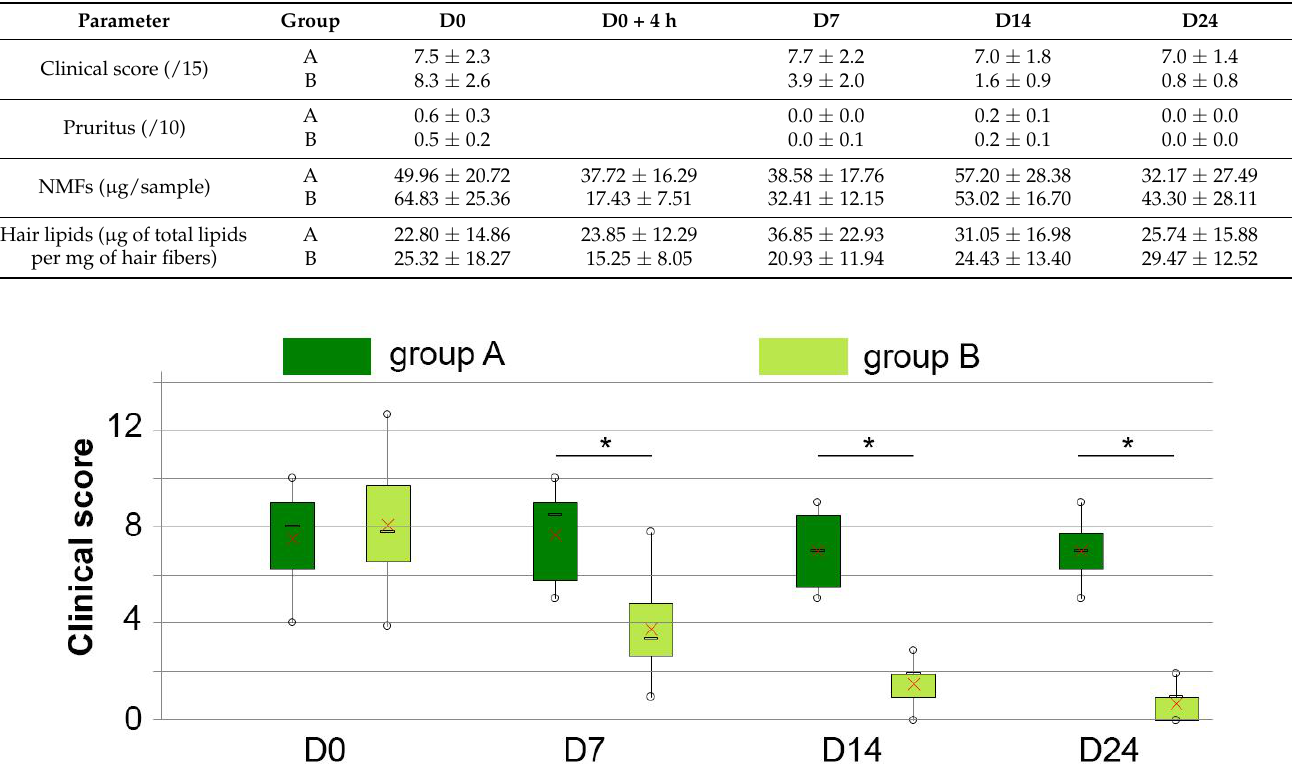
Figure 1. Kinetics of clinical scores in dogs with keratinization disorders that were washed in plain water (group A — dark green boxes) or received DOUXO ® S3 SEB shampoo and mousse (Ceva Santé Animale, France) (group B — light green boxes) at different time points during the study. Interpretation of box and whisker plots: lower and upper box boundaries 25th and 75th percentiles, respectively, line inside box median, lower and upper whiskers minimum and maximum scores, respectively. X represents the mean. * represents significant differences at p = 0.05, compared to baseline values.